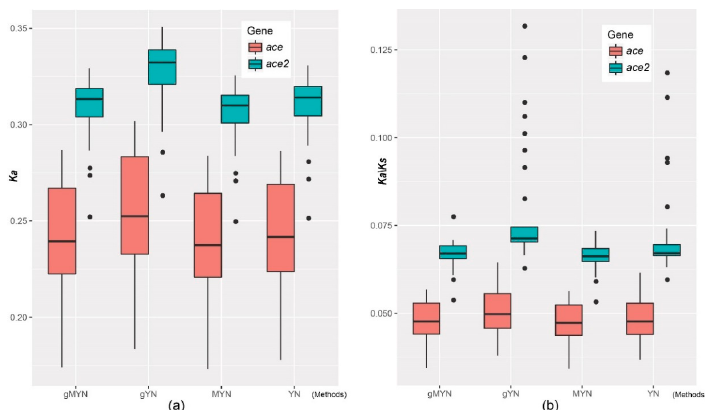
Figure 4. Ka and Ka/Ks values for ace and ace2 coding sequences. The average values of Ka ( a ) and Ka/Ks ( b ) in ace2 using any of the four methods are greater than those of ace .